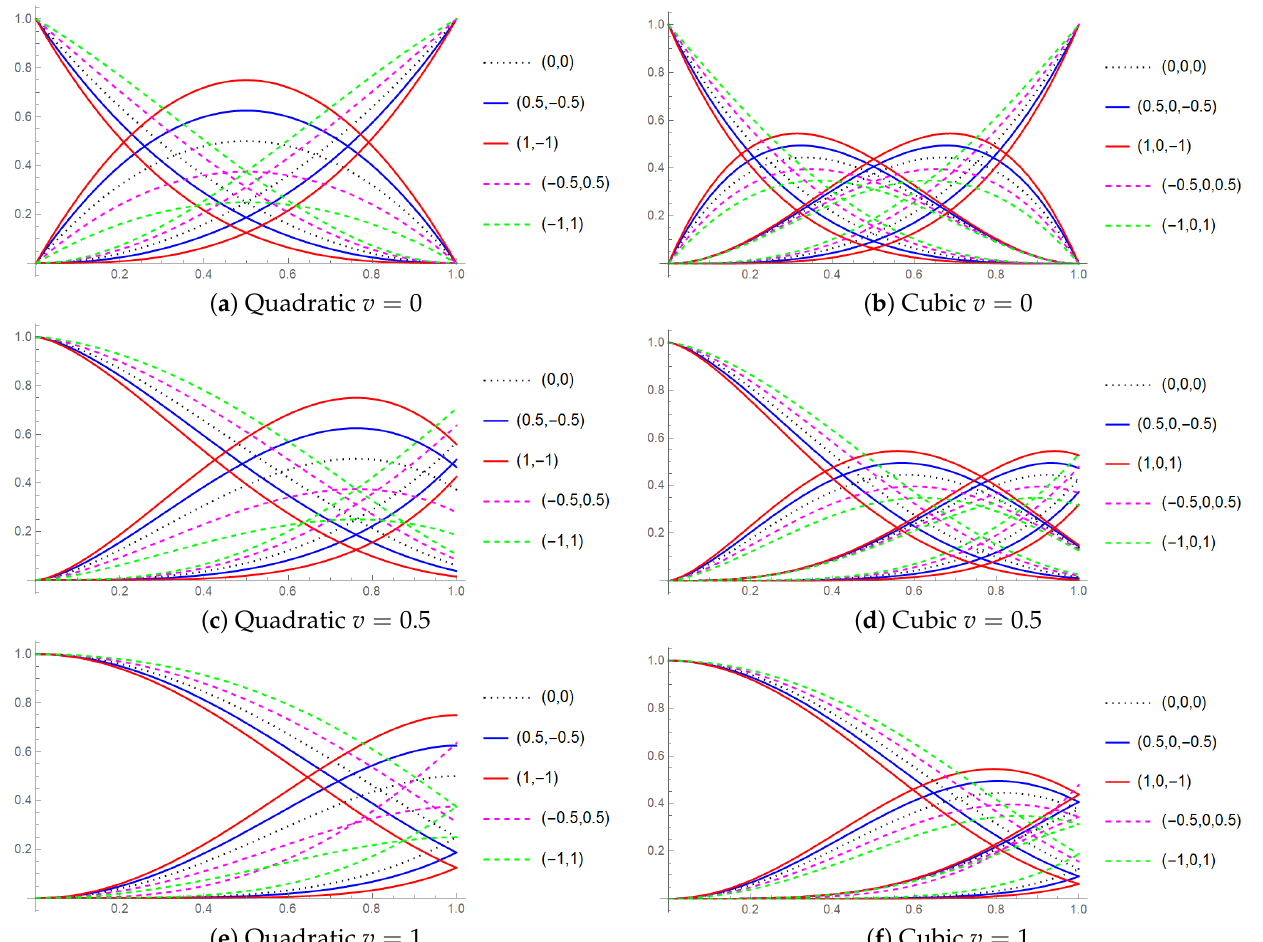
Figure 1. Quadratic and cubic fractional Bézier basis functions with multiple values of v and shape parameters.